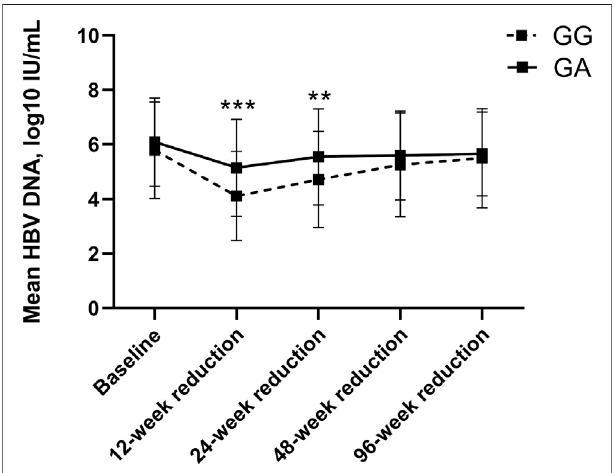
FIGURE 7 | HBA DNA Reduction compared to baseline between wild- type control and heterozygote cases using TDF. Between group differences were not signi fi cant.